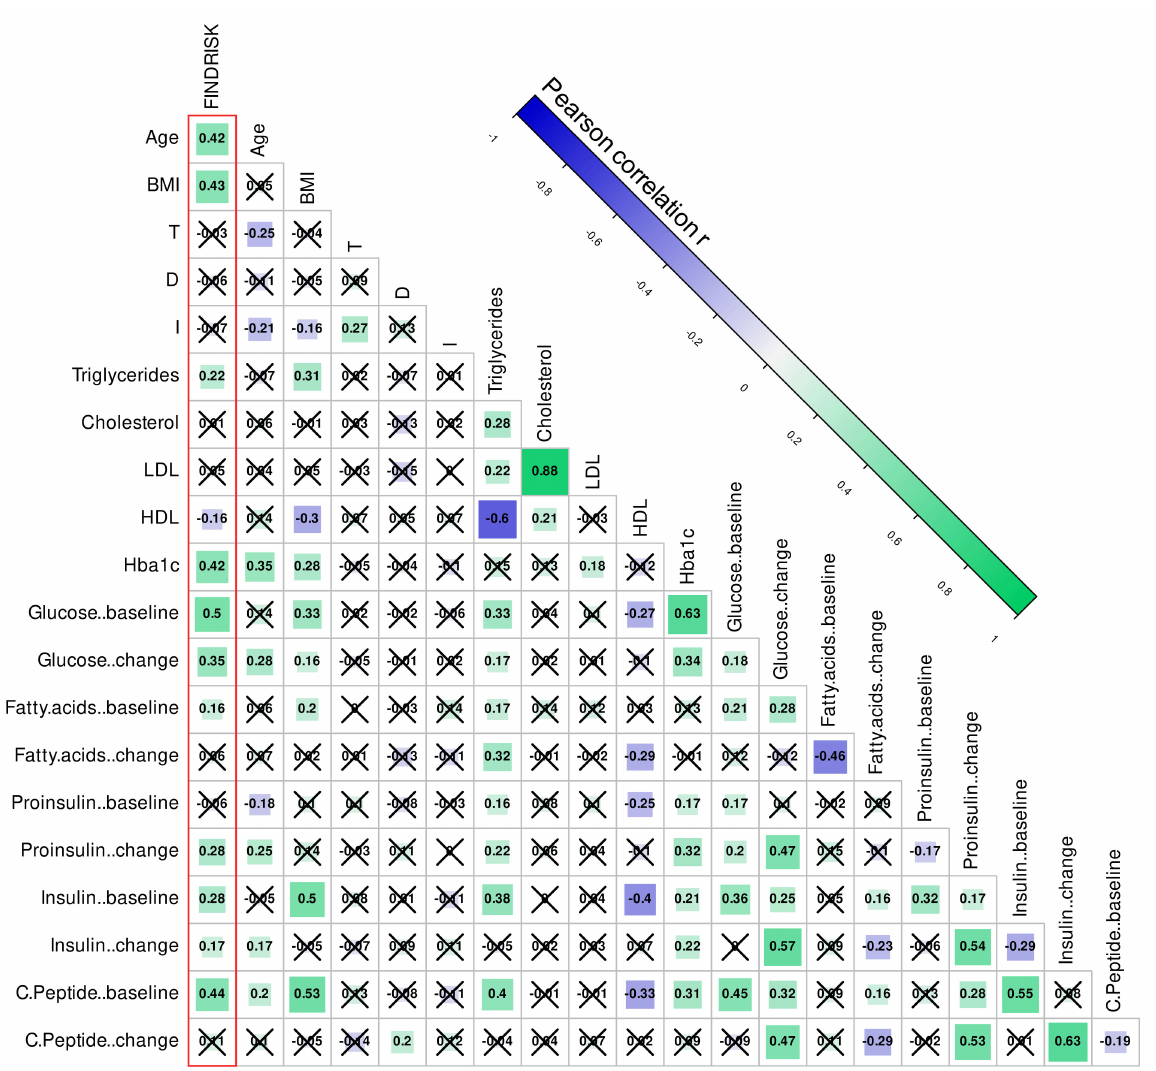
Figure 5. Correlations of metabolomics and olfactory data. Age and BMI are additionally included as control variables. In the lower-left part, the correlations are color-coded for both correlation strength and direction (bars in the upper right corner). The color-coding of the correlation ranges from the blue for a high negative correlation, to gray/white for no correlation, to green for a strong positive correlation. The more intense the color, the higher the correlation. The correlation strength is additionally coded by the size of the square symbolizing the correlation. Cell labels indicate Pearson’s r [114] values, crossed out if not statically significant. Correlations with the FINDRISK score as the main target of this analysis are marked with a red frame. The figure has been created using the R software package (version 4.0.5 for Linux; https://CRAN.R-project.org/ [54]) and the library “corrplot” (https://cran.r-project.org/package=corrplot